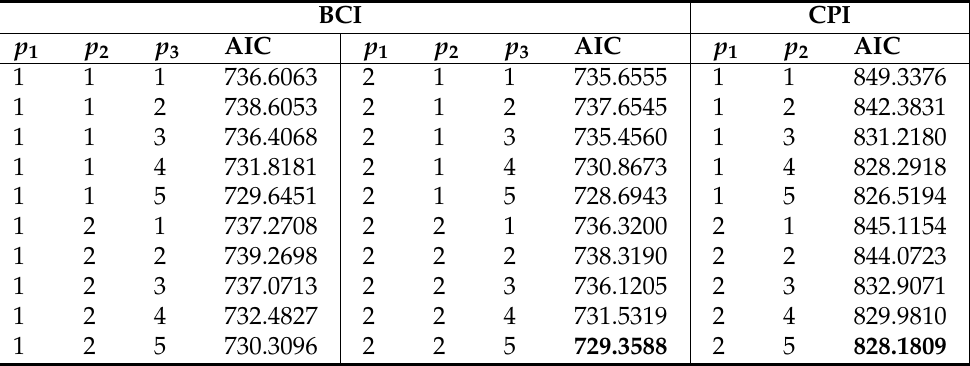
Table 3. AIC for TAR models fitted to BCI and CPI time series. The bold entries highlight the smallest AIC values for each model.